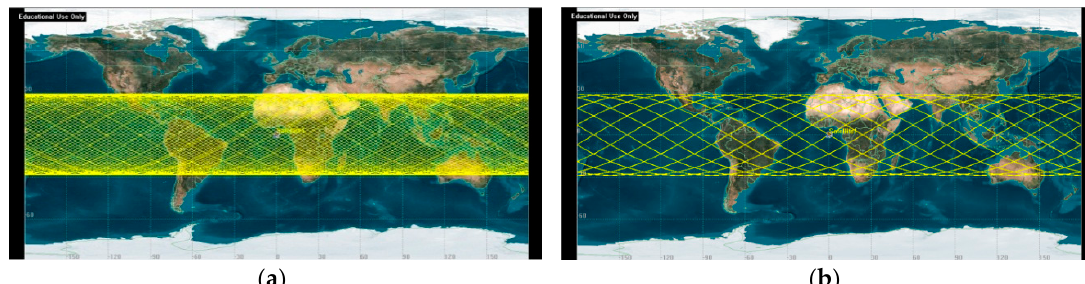
Figure 1. Two observation modes of a ReCon: ( a ) Global observation mode (GOM); ( b ) Regional observation mode (ROM). Note that the satellite is moving along solid lines from left to right in prograde orbits (this case) and vice versa in retrograde orbits.